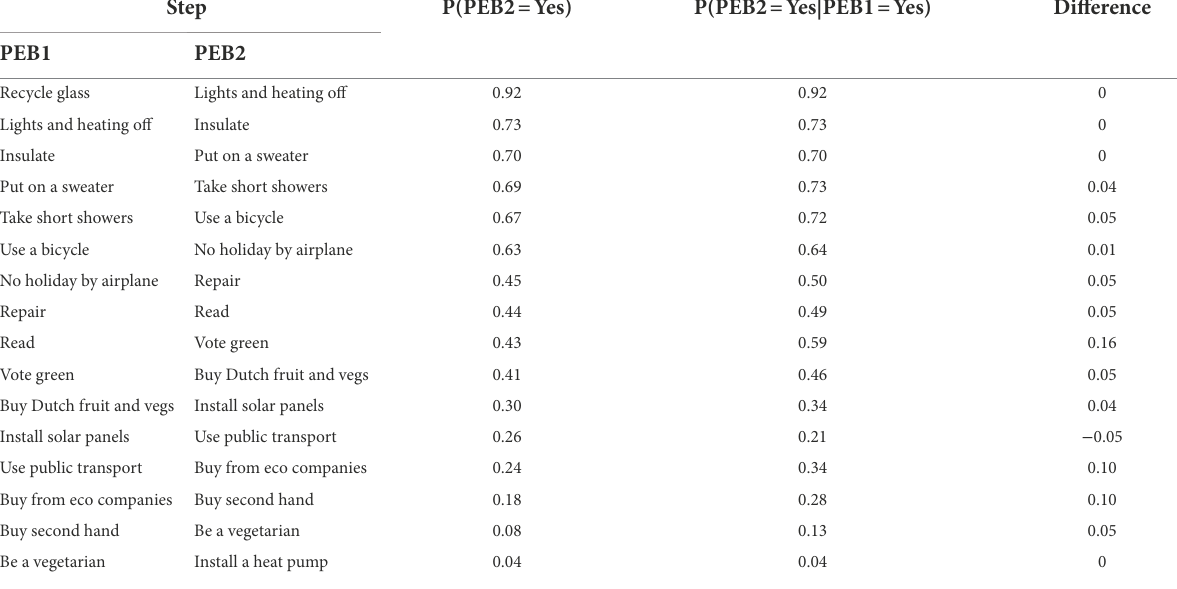
TABLE 2 Unconditional and conditional probabilities of PEB